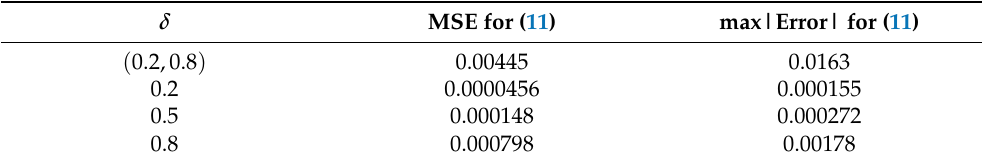
Figure 12. A comparison of parametric PBA-PINN (20), θ 1 ( x , δ ) , n = 3, after two consecutive training weights by minimising the losses (21) and (24), respectively, and an exact solution to the problem for spatial locations: ( a ) x = 0; ( b ) x = 0.5; ( c ) x = 0.9. Table 4. The mean square error (MSE) and the maximum value of the absolute error for PBA-PINNs (20) with n = 3 neurons per a hidden layer after two consecutive training weights by minimising the losses (21) and (24),